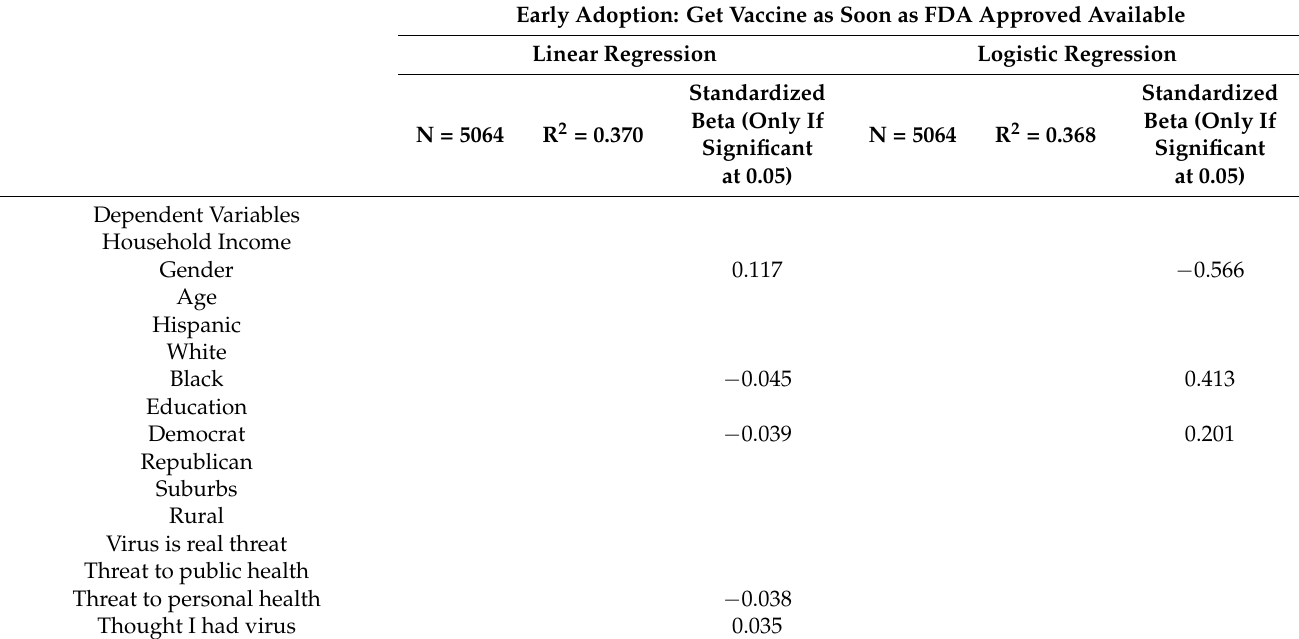
Table A5. Linear and Logistic Regressions of Likelihood of Vaccine Adoption (Very, Somewhat, Not Too, Not at All) by Demographics, COVID Risk and Trust, and General Vaccine Beliefs. Early Adoption: Get Vaccine as Soon as FDA Approved